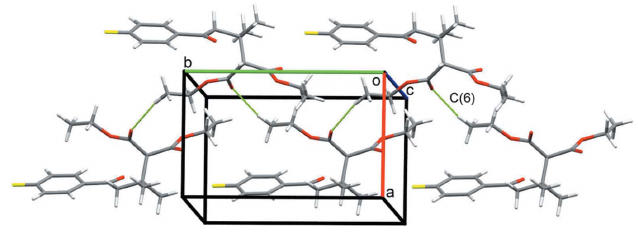
Figure 2 Crystal packing of the title compound. The C—H (cid:2)(cid:2)(cid:2) O hydrogen bonds form infinite chains along the b -axis direction.